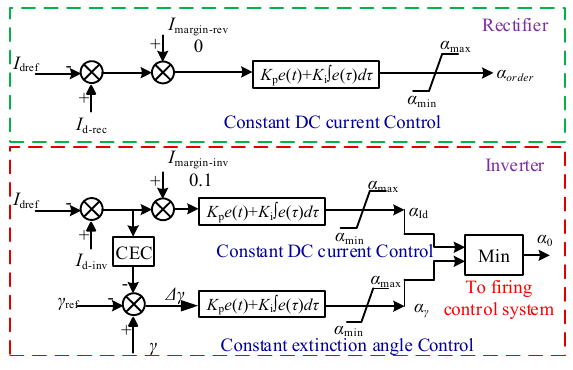
Figure 2. Control mechanism for the LCC-HVDC system.